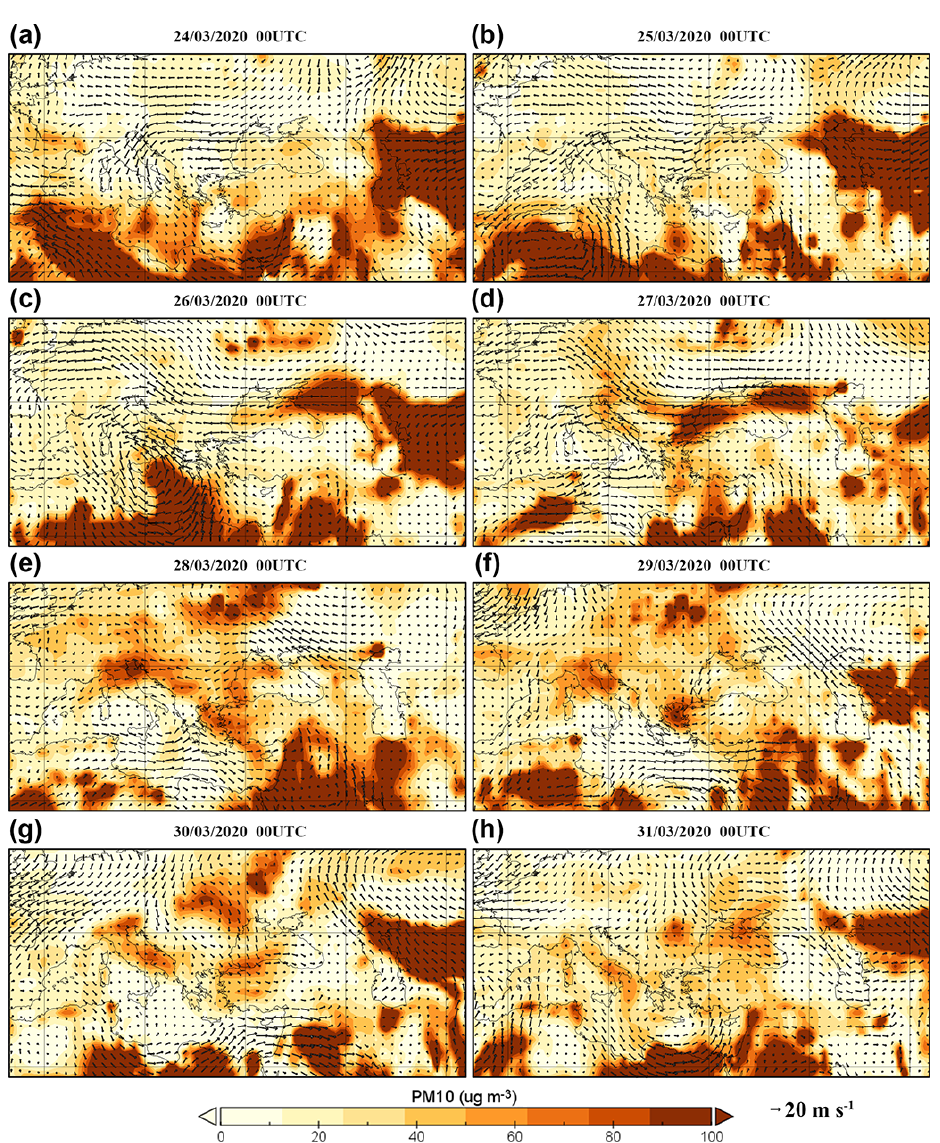
Figure 2. Maps of the PM 10 (colors, in µgm − 3 ) and horizontal surface wind (arrows) relative to each day in the period from 24 to 31 March at 00:00UTC (a–h) . The maps were created with Panoply starting from ERA5 reanalysis. Panels (a) to (h) refer to the respective days